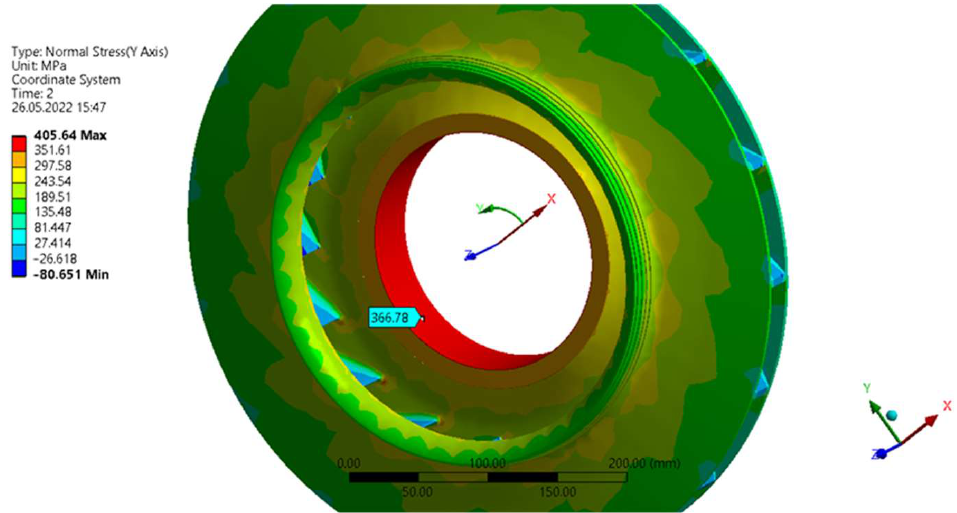
Figure 6. Hoop stress distribution in the impeller, caused by the shrink fit.